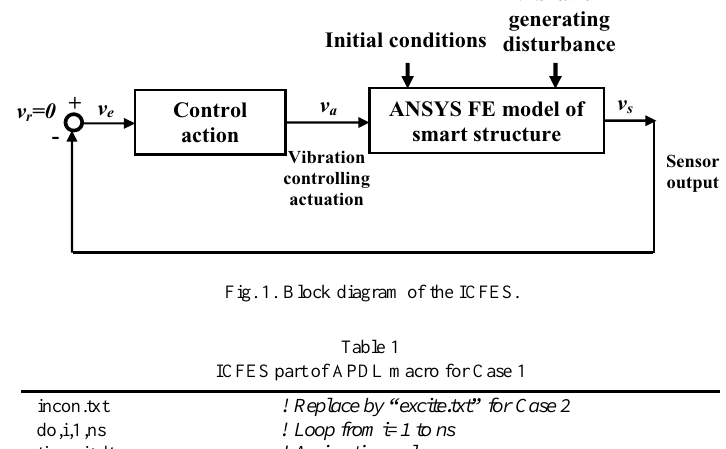
Fig. 1. Block diagram of the ICFES. Table 1 ICFES part of APDL macro for Case